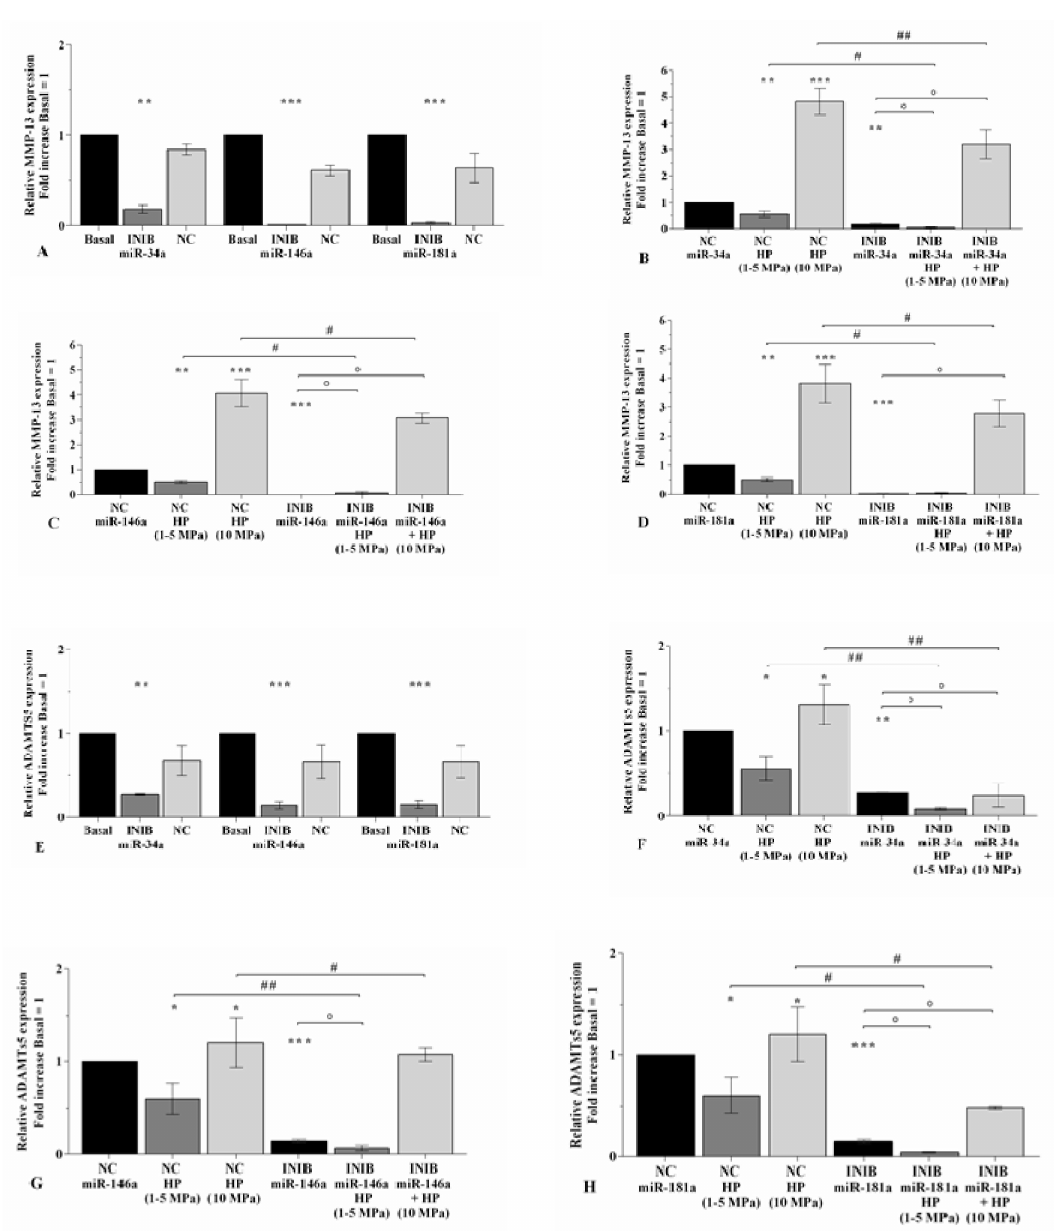
Figure 3. miRNA inhibition reduces the expression of matrix degrading enzymes altered by HP. ( A – H ) Expression levels of MMP-13 and ADAMTS-5 analyzed by real-time PCR. Human osteoarthritic (OA) chondrocytes were evaluated at basal condition, after 24 h of transfection with miR-34a, miR-146a, and miR-181a inhibitors (50 nM) or NC (5 nM), and after 3 h of low sinusoidal (1 – 5 MPa) or static continuous (10 MPa) HP exposure. The gene expression was referenced to the ratio of the value of interest and the value of basal condition or NC, reported equal to 1. Data were expressed as mean ± SD of triplicate values. * p < 0.05, ** p < 0.01, *** p < 0.001 versus basal condition or NC. ◦ p < 0.05 versus inhibitor. # p < 0.05, ## p < 0.01 versus HP. INIB = Inhibitor, NC = negative control